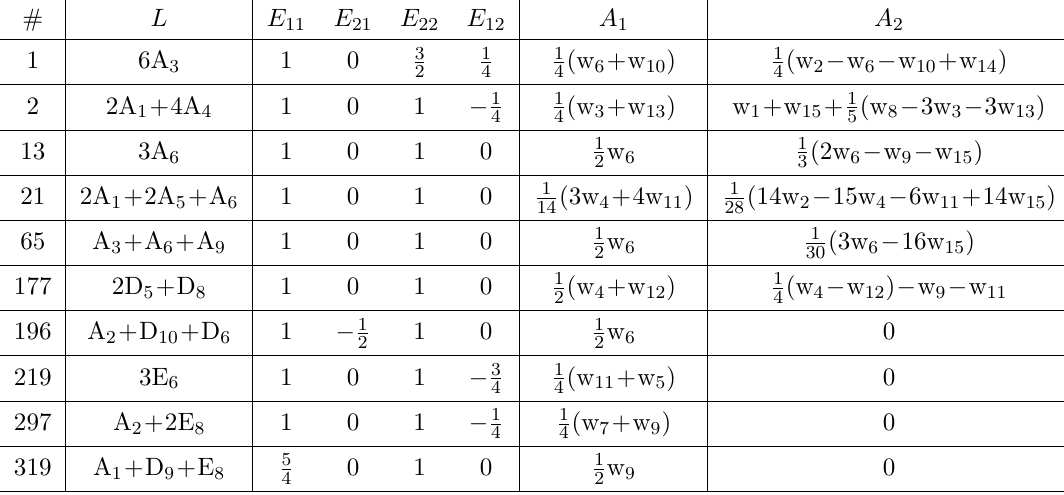
Table 13. Data for some groups of maximal rank, for the Spin(32) = Z 2 heterotic on T 2 .